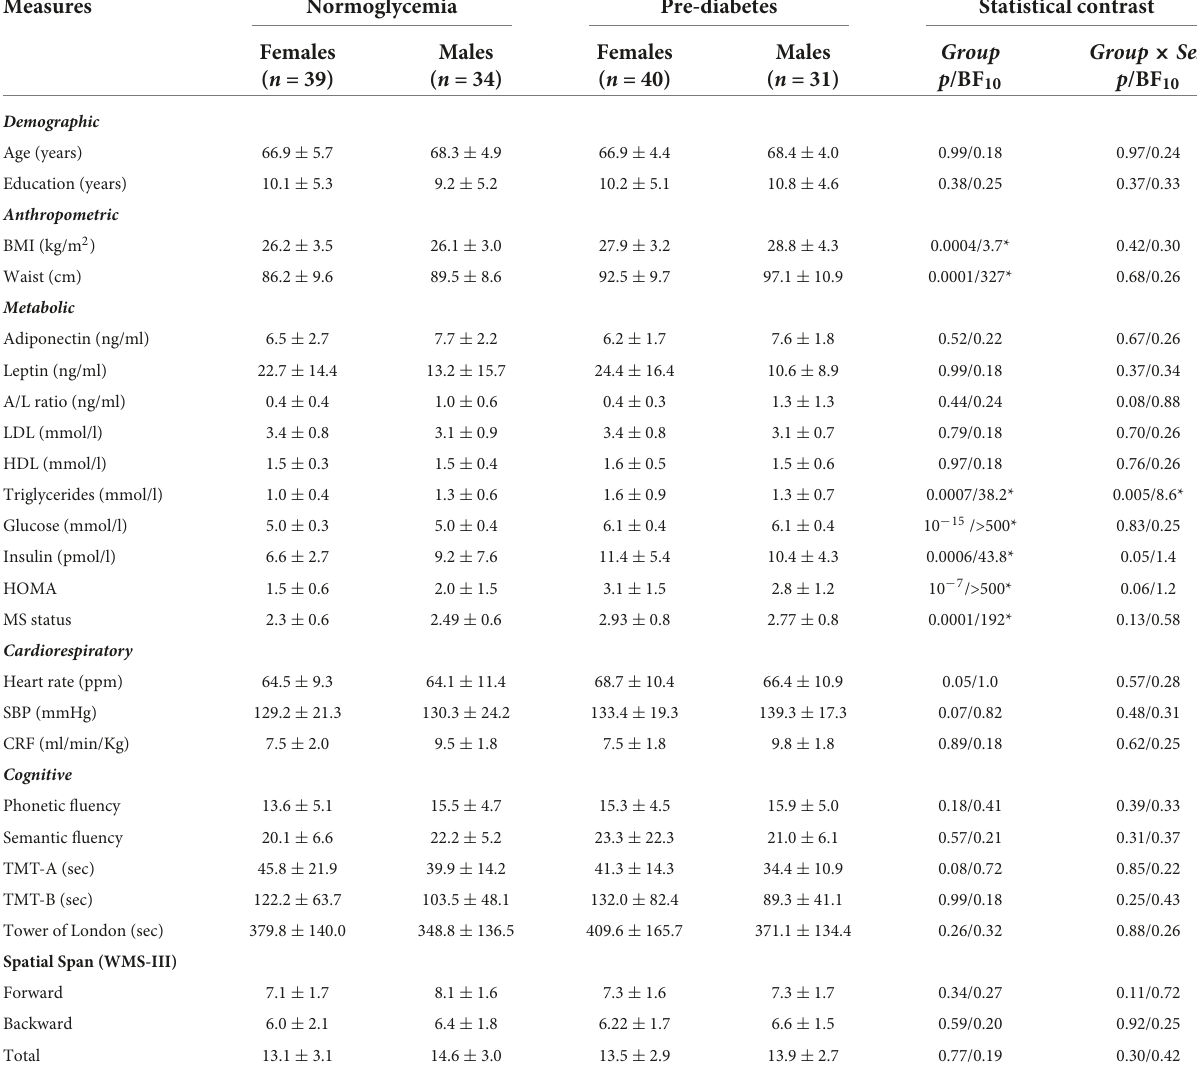
Measures Normoglycemia Pre-diabetes Statistical